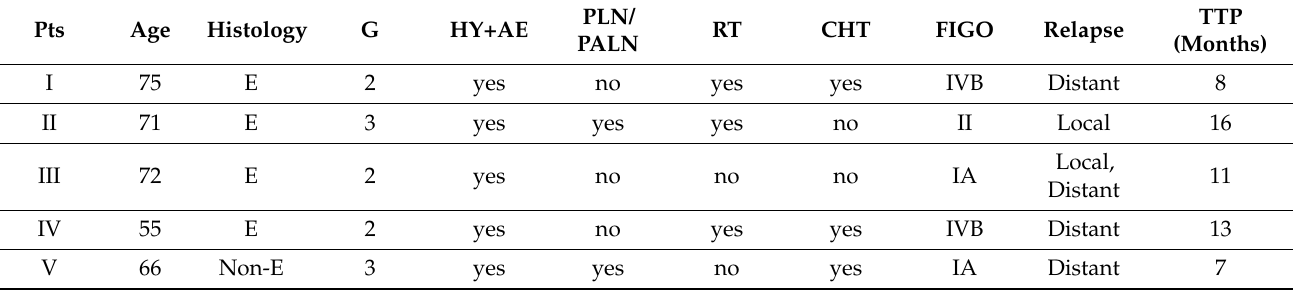
Table 2. Characteristics of patients with recurrent endometrial cancer.